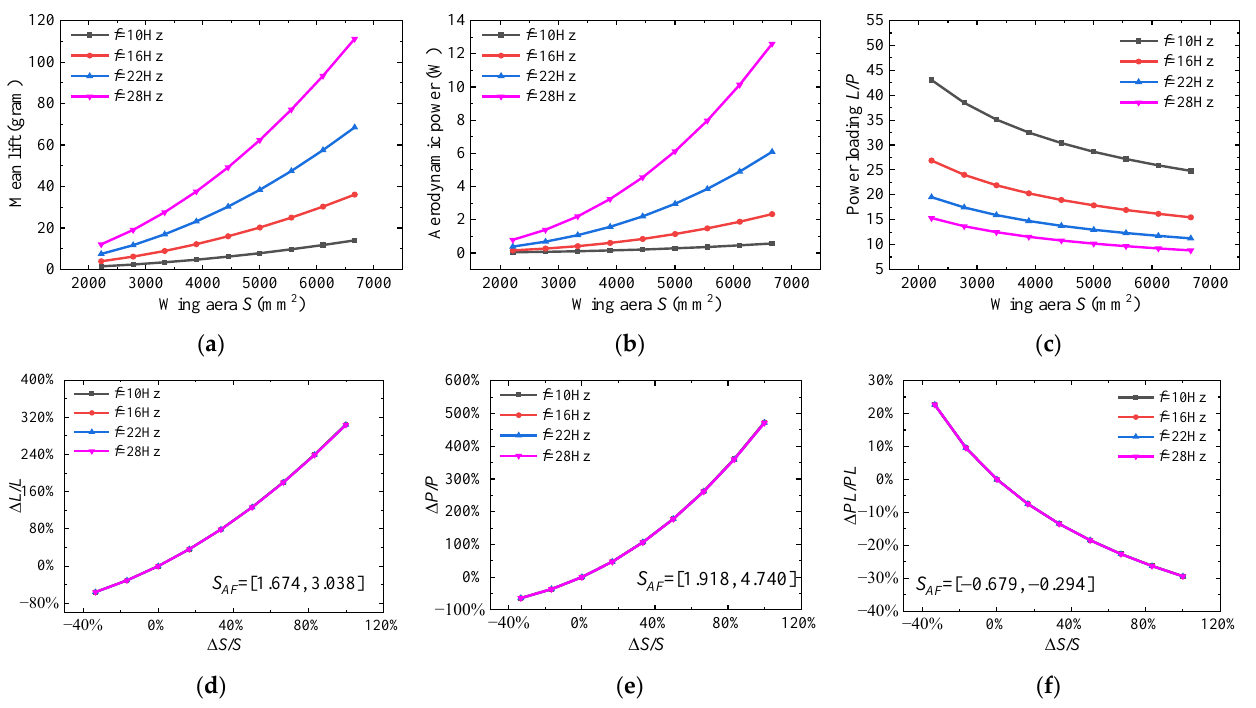
Figure 7. Sensitivity analysis for wing surface area S . ( a ) Mean lift of different S . ( b ) Aerodynamic power of different S . ( c ) Power loading of different S . ( d ) Variation of lift vs. variation of S . ( e ) Variation of aerodynamic power vs. variation of S . ( f ) Variation of PL vs. variation of S . Linear fitting was also performed on the log-transformed data to obtain the relation- ship between S and corresponding aerodynamic performance. A similar linear relation- ship can also be found in Figure 8, indicating that wing surface area S also satisfies the exponential assumption in Equation (39). Table 6 gives the exponent values obtained by result in Equations (1) – (3). The constant b , the intercept of the fitted line, is related to the flapping frequency, which is not presented here.